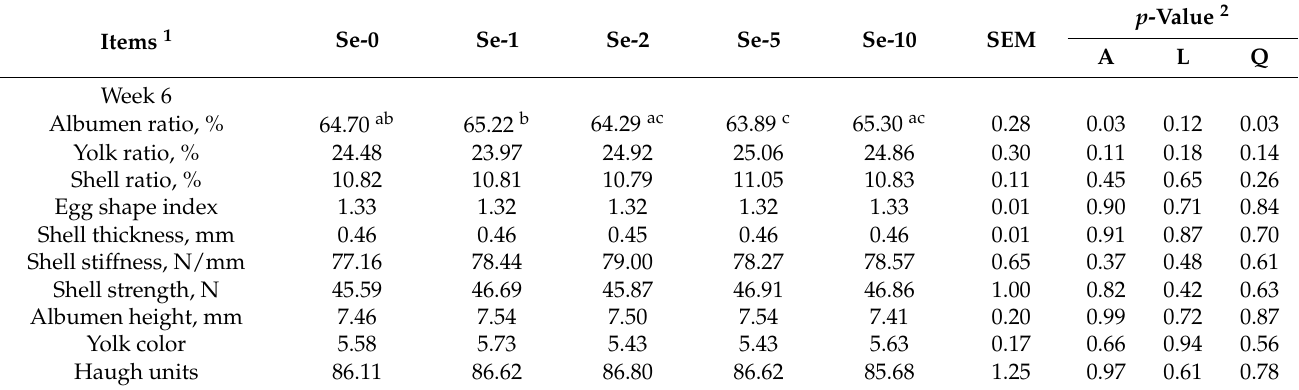
Table 4. Effects of dietary organic selenium on the egg quality of laying